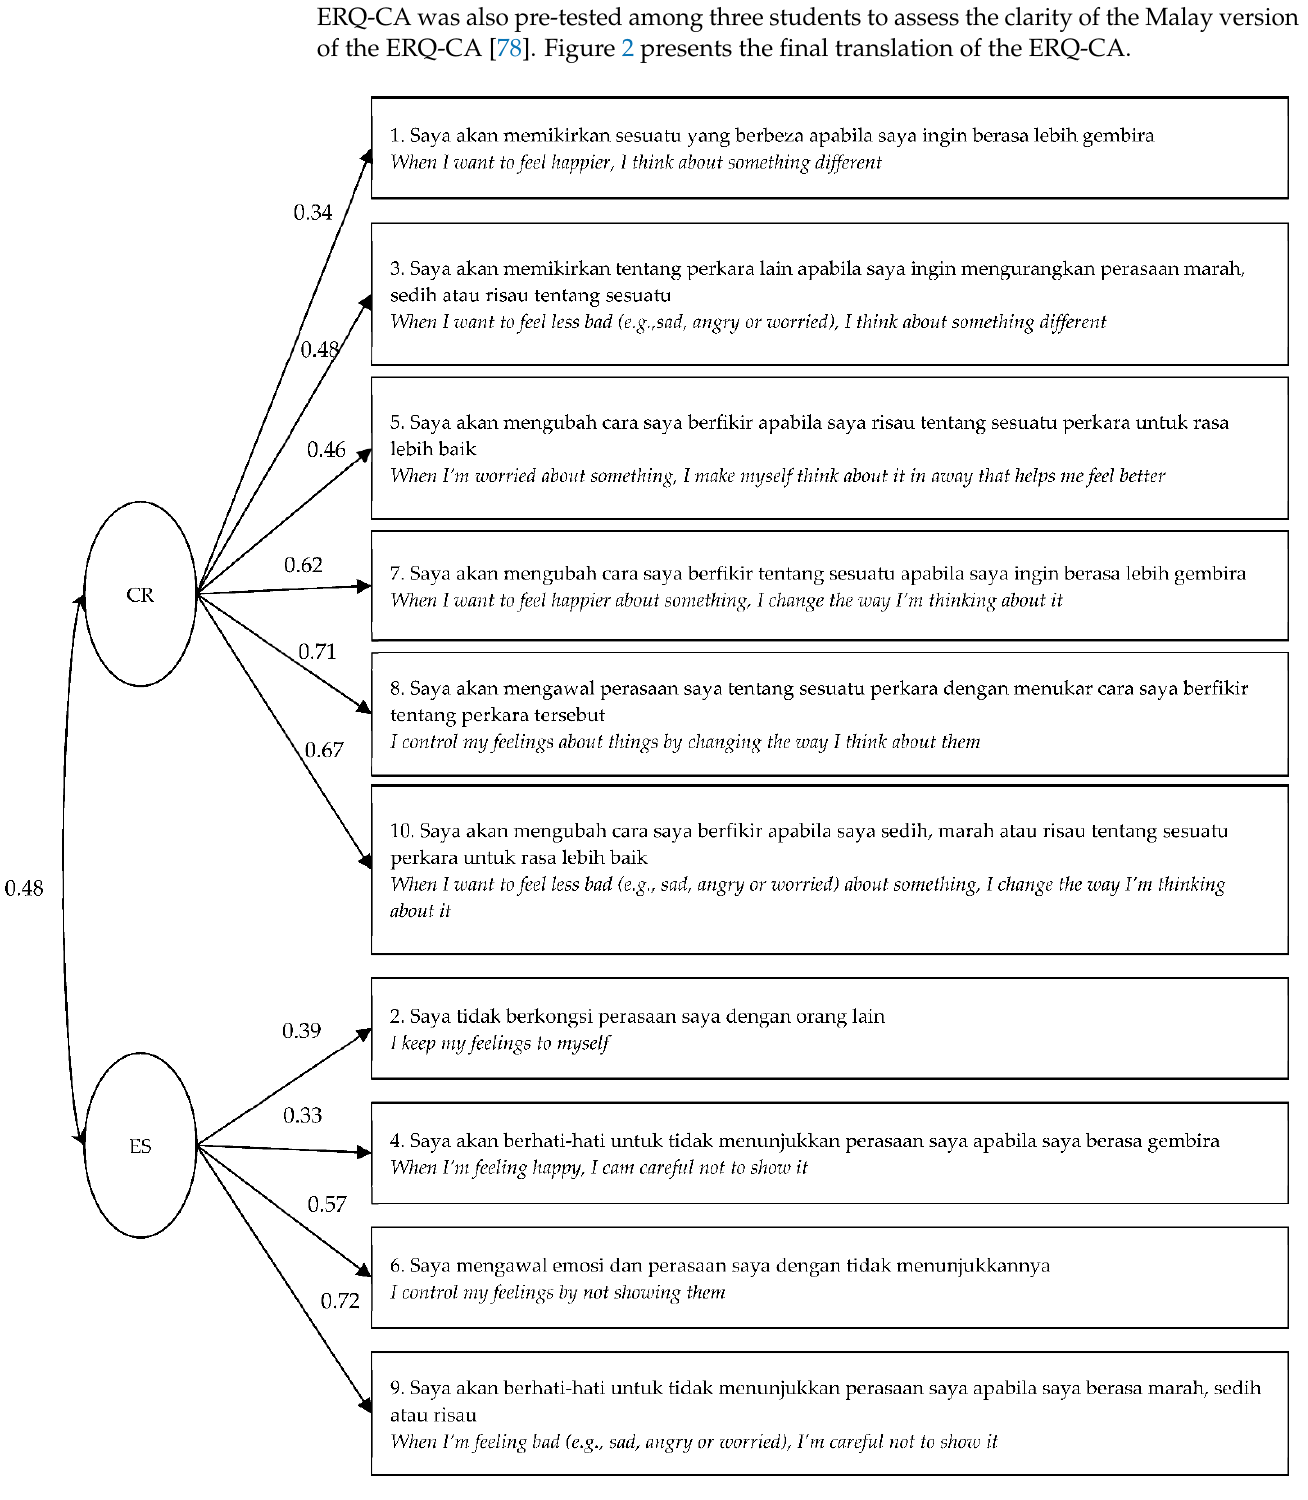
Figure 2. The Malay translation and the confirmatory factor analysis model of the Malay version of the ERQ-CA. The paths indicate the standardized regression coefficients for the 13- and 14-year- old sample.